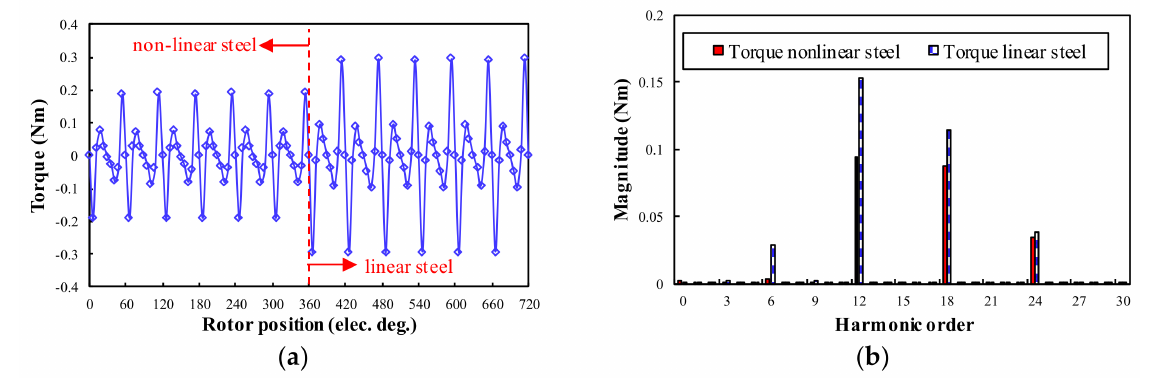
Figure 5. Cogging torque waveforms and spectra for 12/4 WRSM: ( a ) Waveforms; ( b ) Spectra.